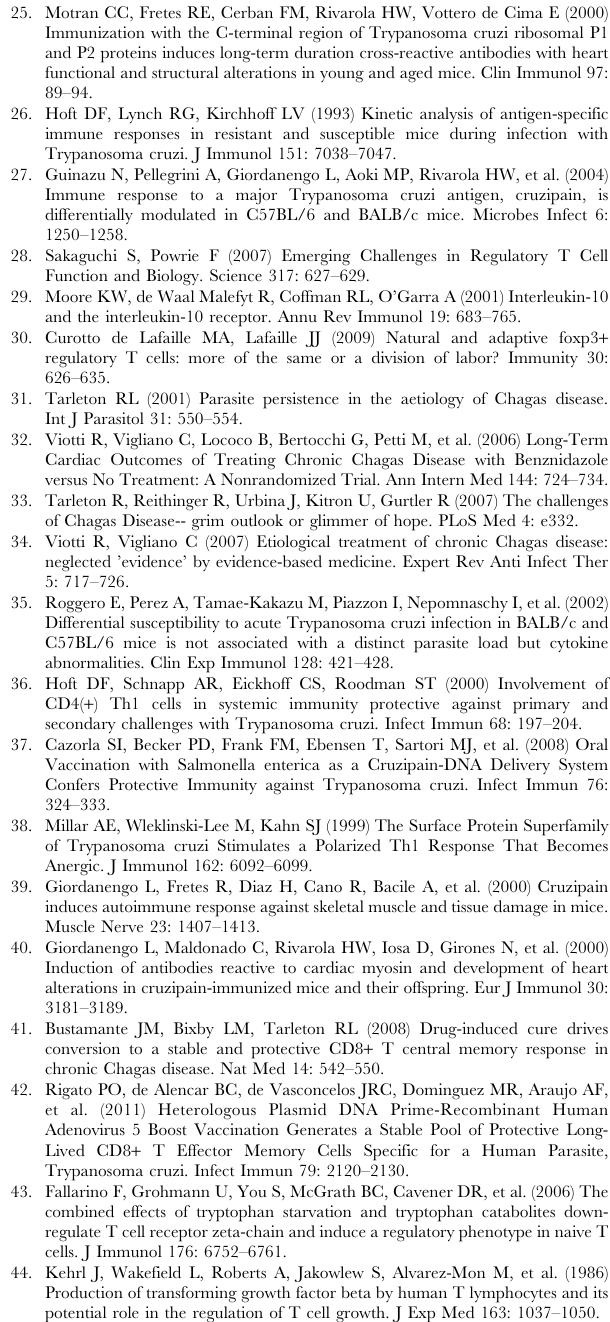
Figure S1 Comparison of the total numbers of CD4 + , CD8 + and CD8 + /CD4 + cells ratio in the spleens of 3-HK and control mice at 16, 30 and 60 dpi. Results are means 6 SD of 4 mice/group. One representative of two experiments is